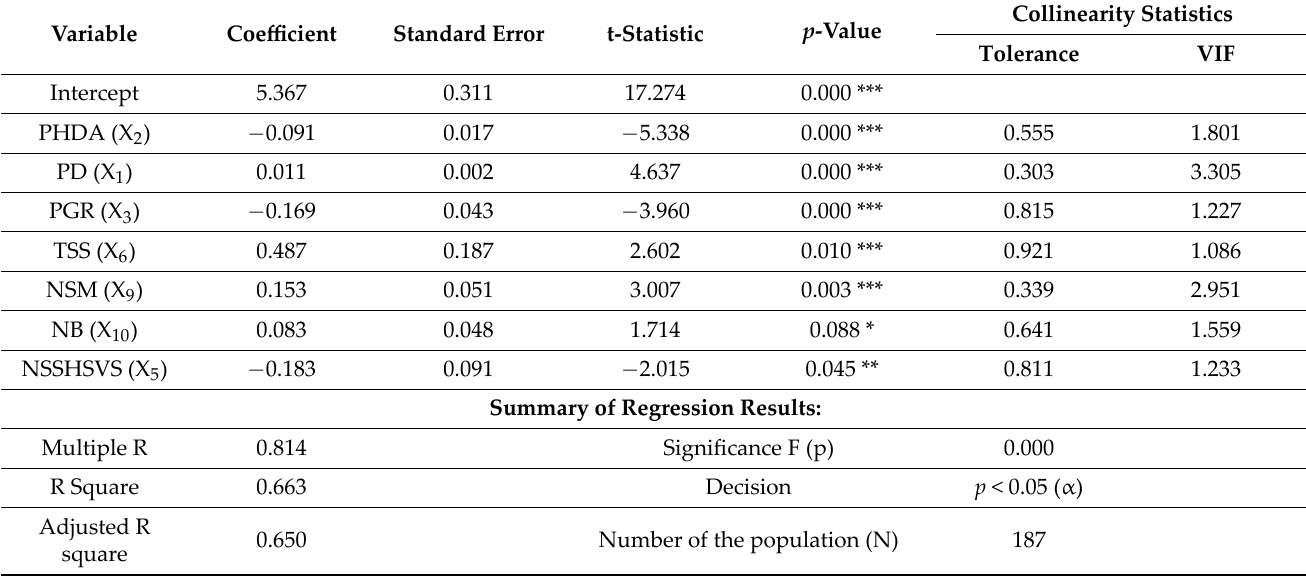
Table 4. OLS regression results